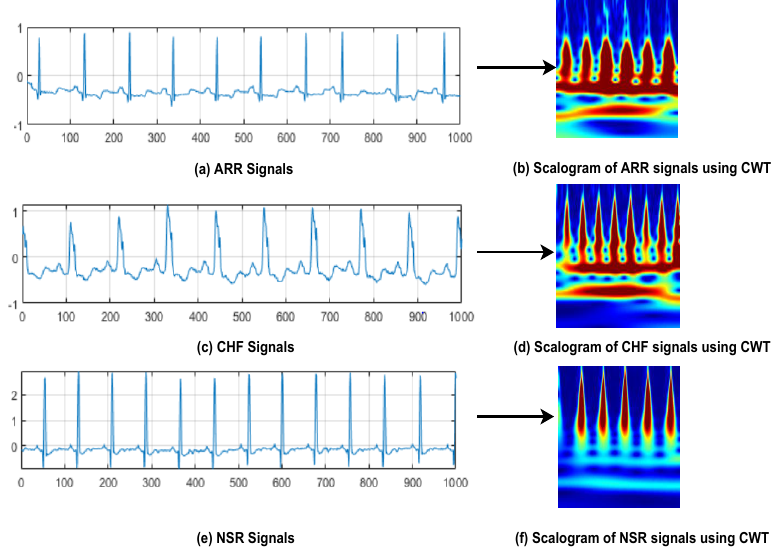
Figure 2. Distribution of ECG waveforms from three classes of arrhythmias. Sub-figures ( a , b ) Represents ARR signals and Scalogram image of ARR signal using CWT; Sub-figures ( c , d ) Represents CHF signals and Scalogram image of CHF signal using CWT; Sub-figures ( e , f ) Represents NSR signals and Scalogram image of NSR signal using